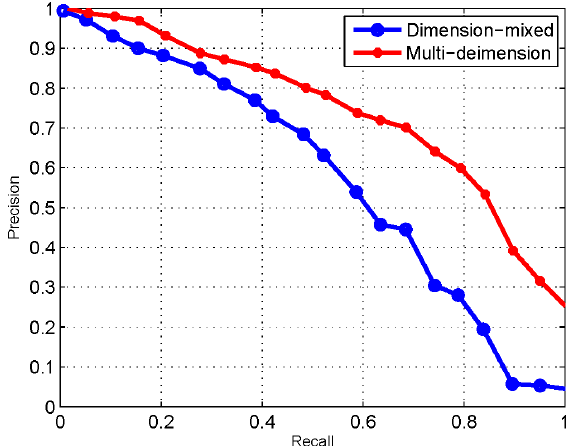
Figure 6. The performance of dimension-mixed and multidimensional.